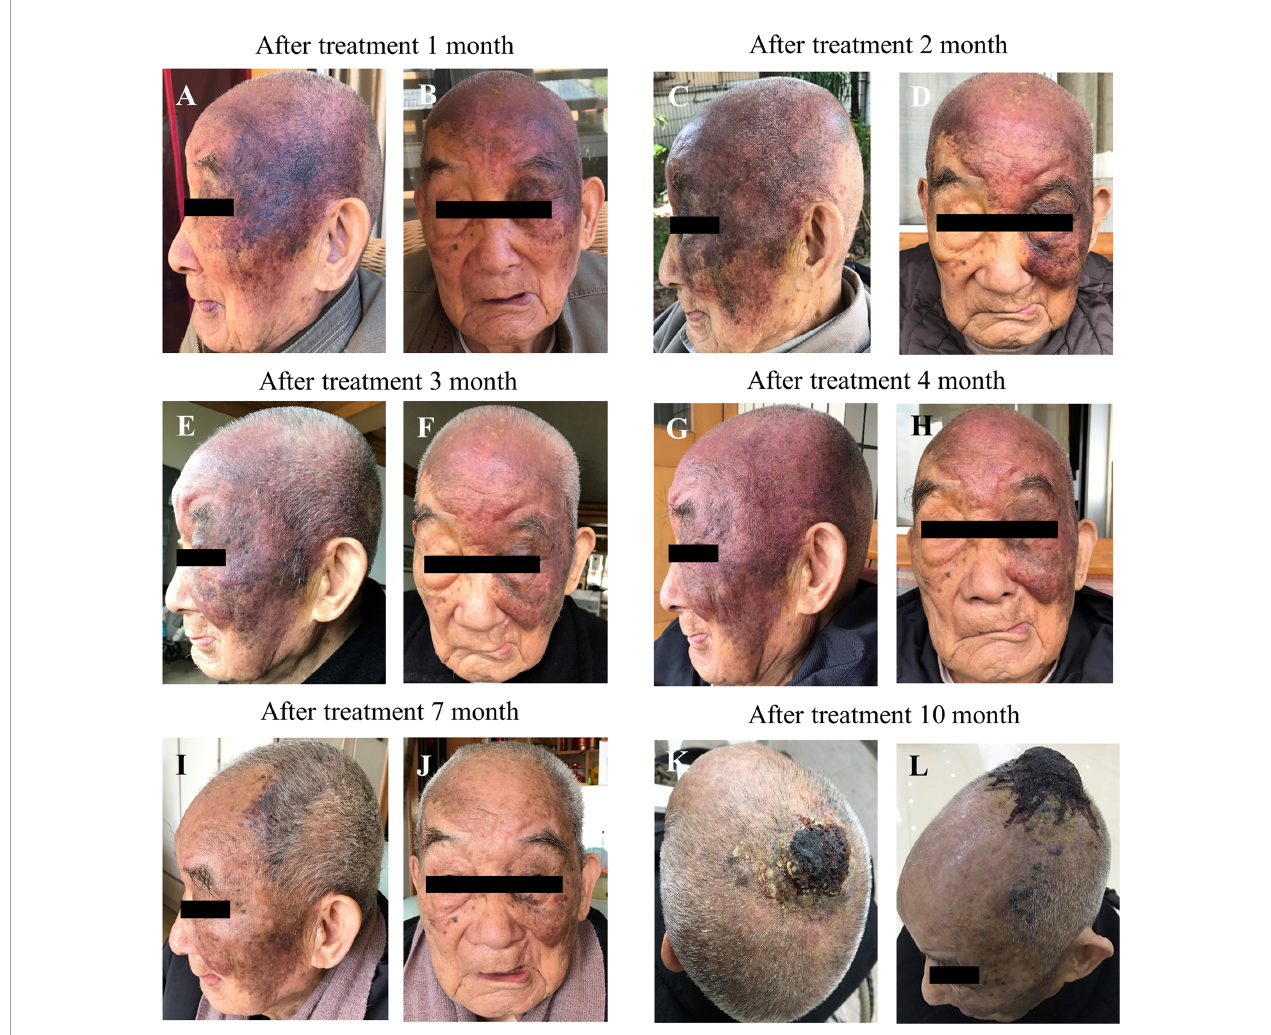
FIGURE 2 | Effect of anlotinib on scalp and facial lesion changes over a course of 10 months treatment. (A – J) left side lateral view and right side frontal view, (K – L) superior